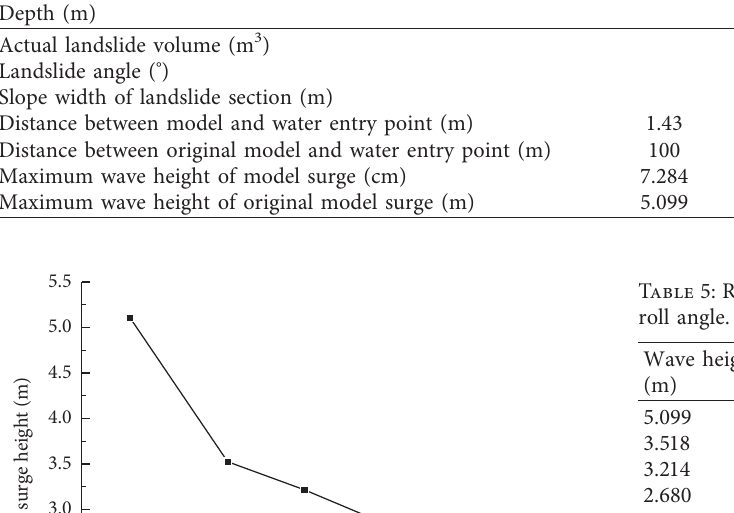
Table 4: Properties of landslide-generated tsunamis.